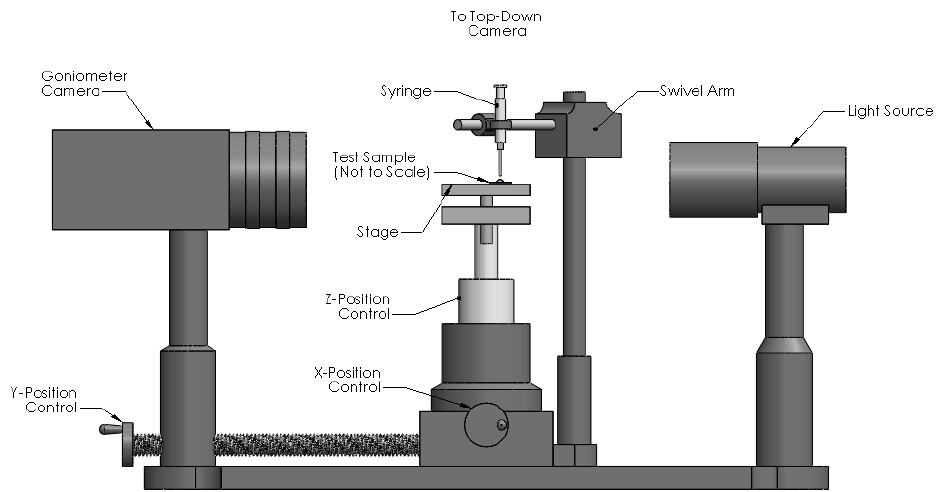
Figure 3. Diagram showing the droplet deposition test set up.